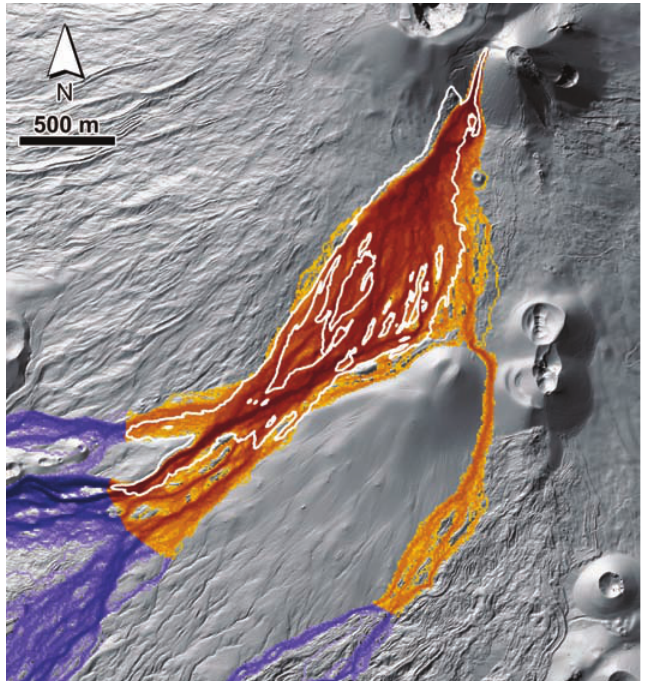
Figure 3. Comparison between real (white lines) and simulated (colored areas) lava-flow paths for the 2006 southern lava-flow field. Lighter and darker colors, higher or lower frequencies of simulated lava-flow passage, respectively. Red hues, areas located at a distance from the vent lower than the maximum distance attained by the real lava flows.